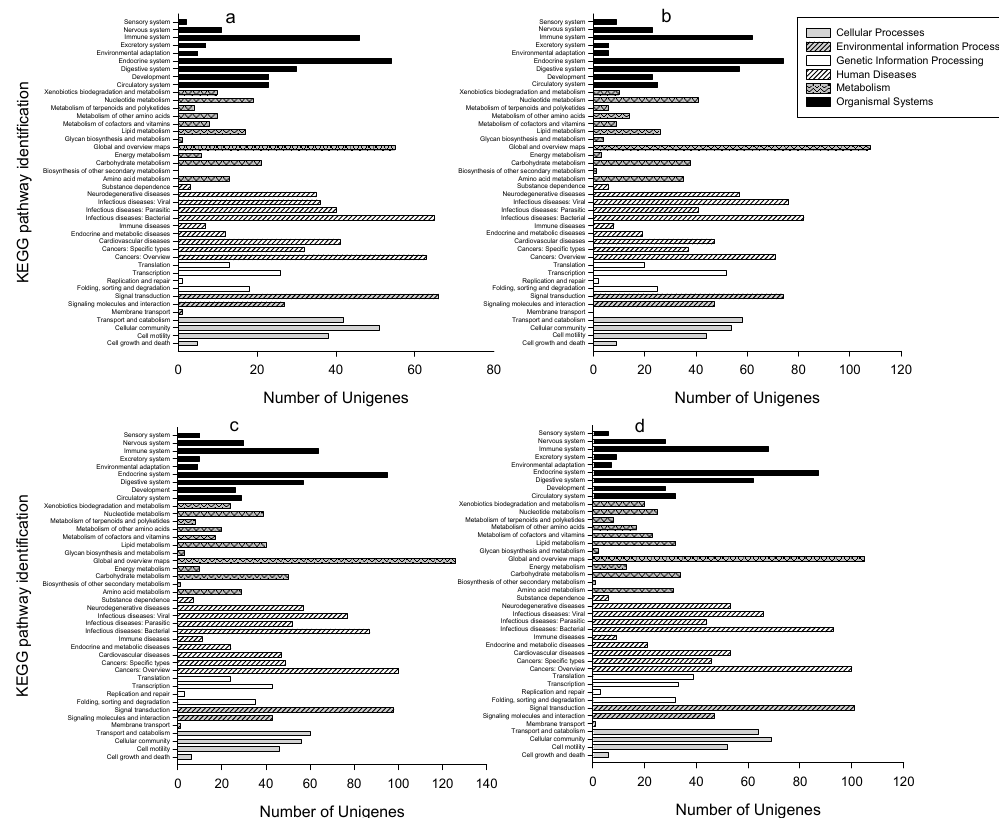
Figure 5. Number of DEUs assigned to KEGG pathway enrichment using different insecticides and different time durations in comparison with control. ( a ) treatment with chlorpyrifos for 6 h versus control, ( b ) treatment with chlorpyrifos for 48 h versus control, ( c ) treatment with clothianidin for 6 h versus control, ( d ) treatment with clothianidin for 48 h versus control. Table 2. Most significant DEUs in control samples vs. those exposed to chlorpyrifos for 48 h.